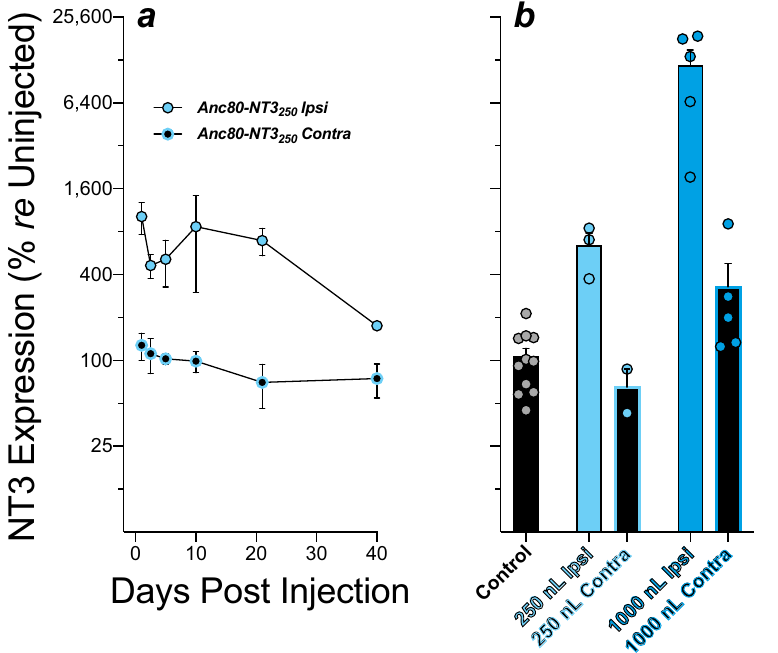
Figure 3. Virally mediated increases in cochlear NT3 expression, as assessed by qRT-PCR. ( a ) NT3 mRNA levels in injected and contralateral cochleas at post-injection days 1, 2.5, 5, 10, 21 and 40, normalized to mean levels in the contralateral ears. ( b ) To assess contralateral spread of the virus, NT3 mRNA levels were measured in both ears at 21 days post-injection and normalized to levels in uninjected controls. Histograms show means and SEMs; individual cases are shown by the colored circles in b